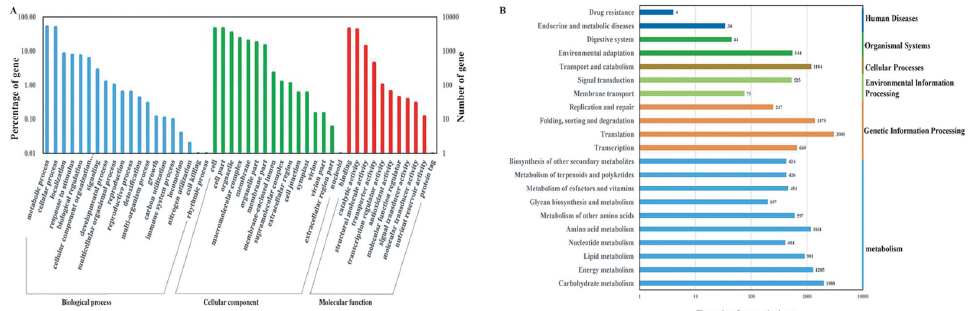
Fig 4. (A) GO functional classification of the unigenes. Blue indicates biological process, green indicates cellular process, and red represents molecular function. The axis labels are “Percentage of genes” (on the left) and “Number of genes” (on the right). (B) KEGG pathway analysis of the unigenes. The x-axis indicates the number of unigenes in a specific category. The left y-axis indicates the clustered functional groups, and the right y-axis indicates the specific category of the genes in the main